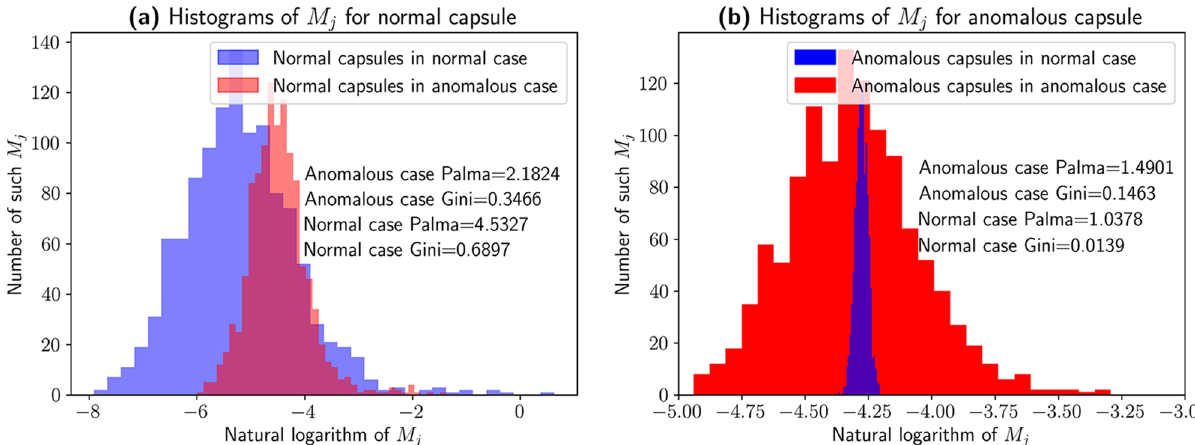
Figure 2. An example of coupling coefficients distributions M j for the data from KuzushijiMNIST. The histograms of M j [Eq. (2)] for normal and anomalous capsules in normal and anomalous cases are shown with specified Gini and Palma coefficients. Note the difference between the distributions for normal ( a ) and anomalous ( b ) capsules in the normal case and the anomalous one. Normal capsule only mildly captures the difference between the samples. We use the couplings of anomalous capsule to compute Gini and Palma coefficients to capture this more pronounced difference for anomalous capsule. Note that on the plot,